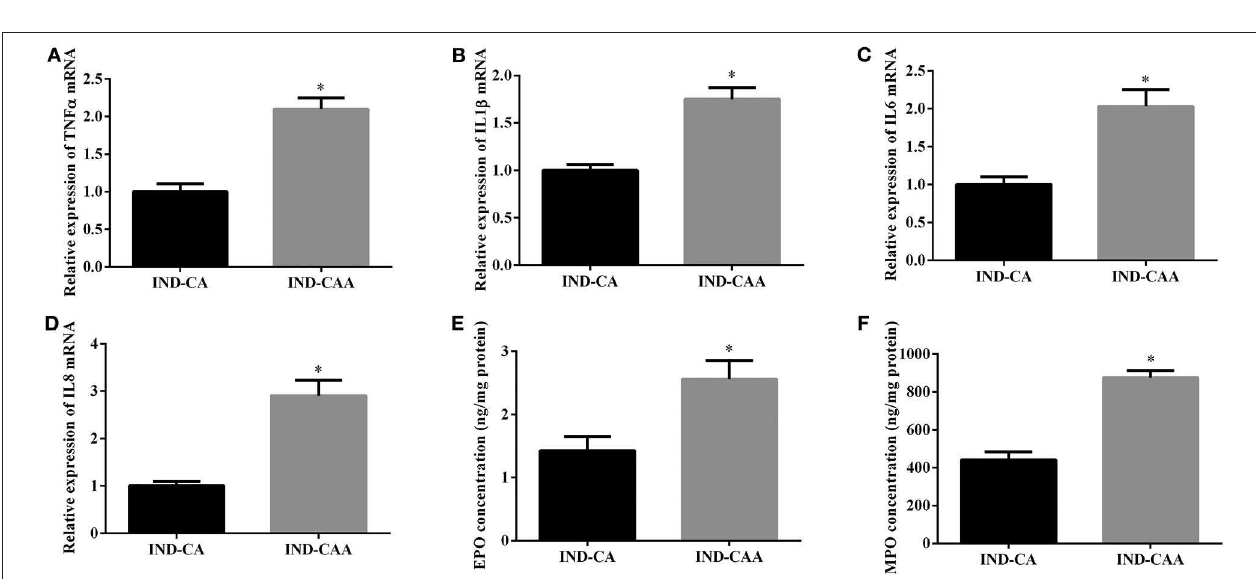
FIGURE 5 | Microbiota depletion by antibiotics blocked the anti-inflammatory effect of chlorogenic acid in indomethacin-treated mice. Relative mRNA expression of TNF α (A) , IL1 β (B) , IL6 (C) , and IL8 (D) ; EPO (E) and MPO (F) concentrations in colonic tissue. Values are expressed as mean ± SEM, n = 8. * P <